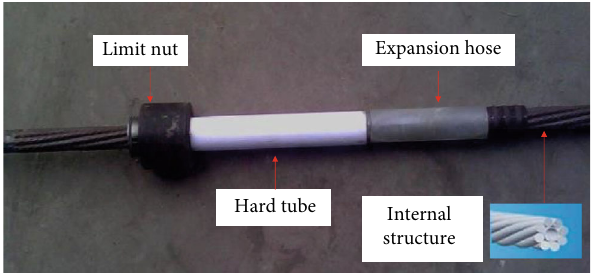
Figure 5: Grouting cable